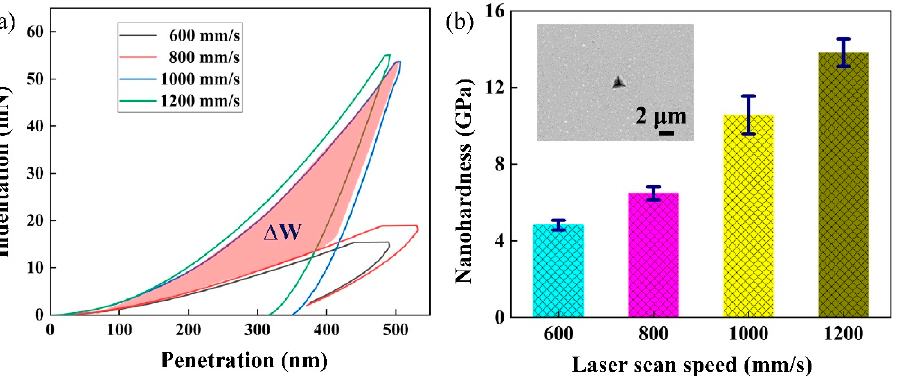
Figure 5. ( a ) Representative nano-indentation load–depth curves for SLM-processed Nb-18Si-5HfC alloys; ( b ) average nano-hardness with different scan speeds (the inset shows a typical nano-indentation morphology).